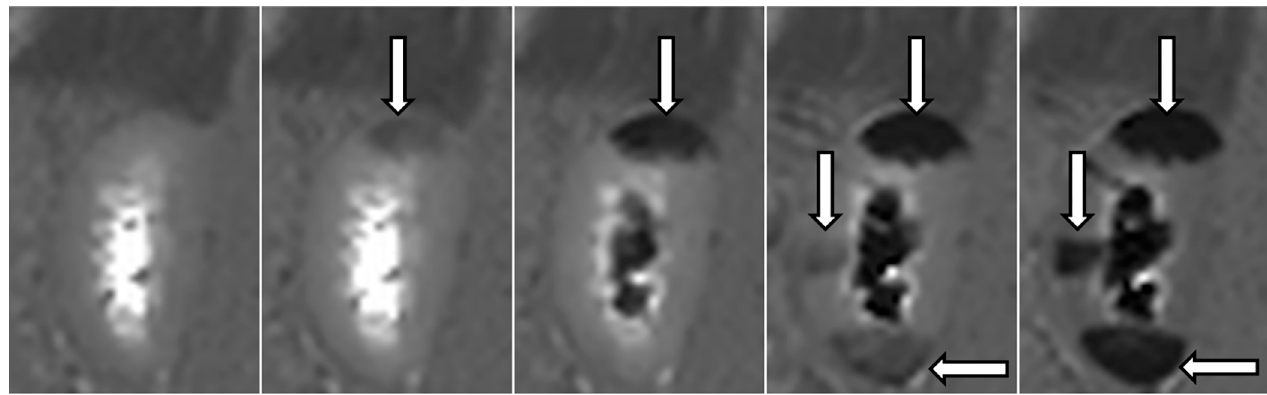
Fig 3. Time series MR. Time series of MR-scans in 1 animal from baseline (0 mins) to end scan (80 mins) showing increased T1 values with rising intraluminal pressure (10 mmhg– 50 mmHg) in the right kidney. 0 min—10 mmHg 20 min– 22 mmHg 40 min– 31 mmHg 60 min– 40 mmHg 80 min– 50 mmHg.